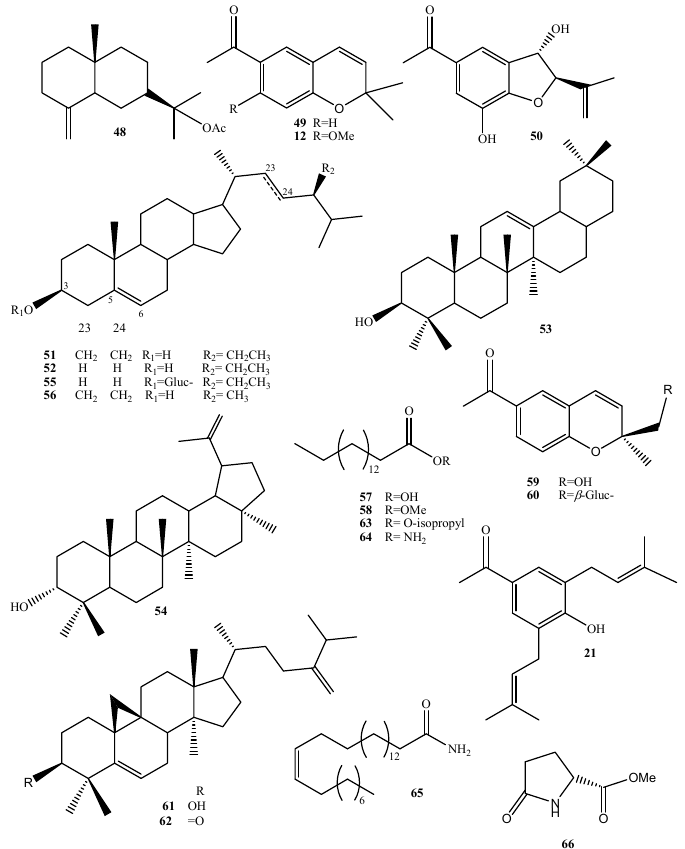
Figure 7. Compounds identified in callus and cell suspension cultures of A. pichinchensis.